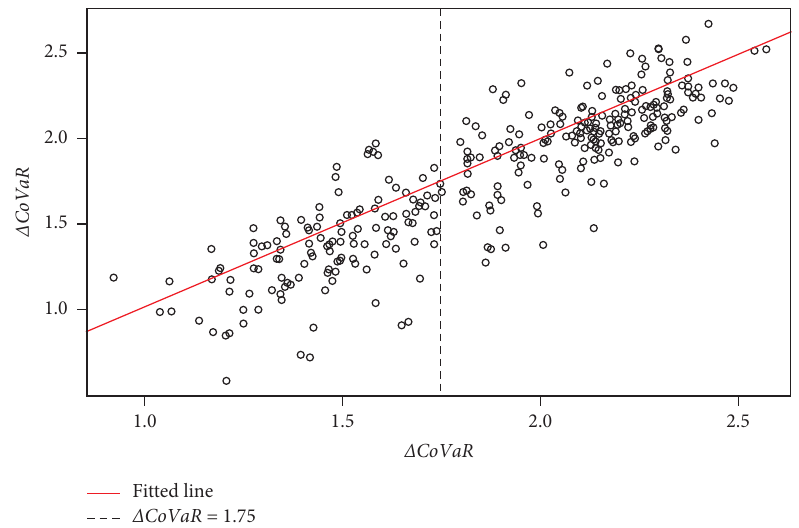
Figure 10: Scatter plot of ∆ CoVaR and ∆ CoCVaR